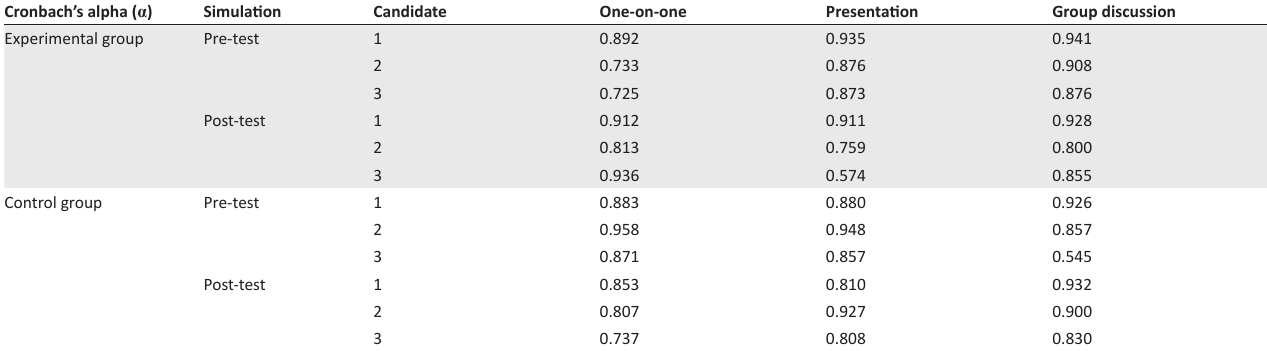
TABLE 2: The Cronbach’s alphas ( α ) between the pre- and the post-test for the experimental and control group for the AC. Cronbach’s alpha ( α